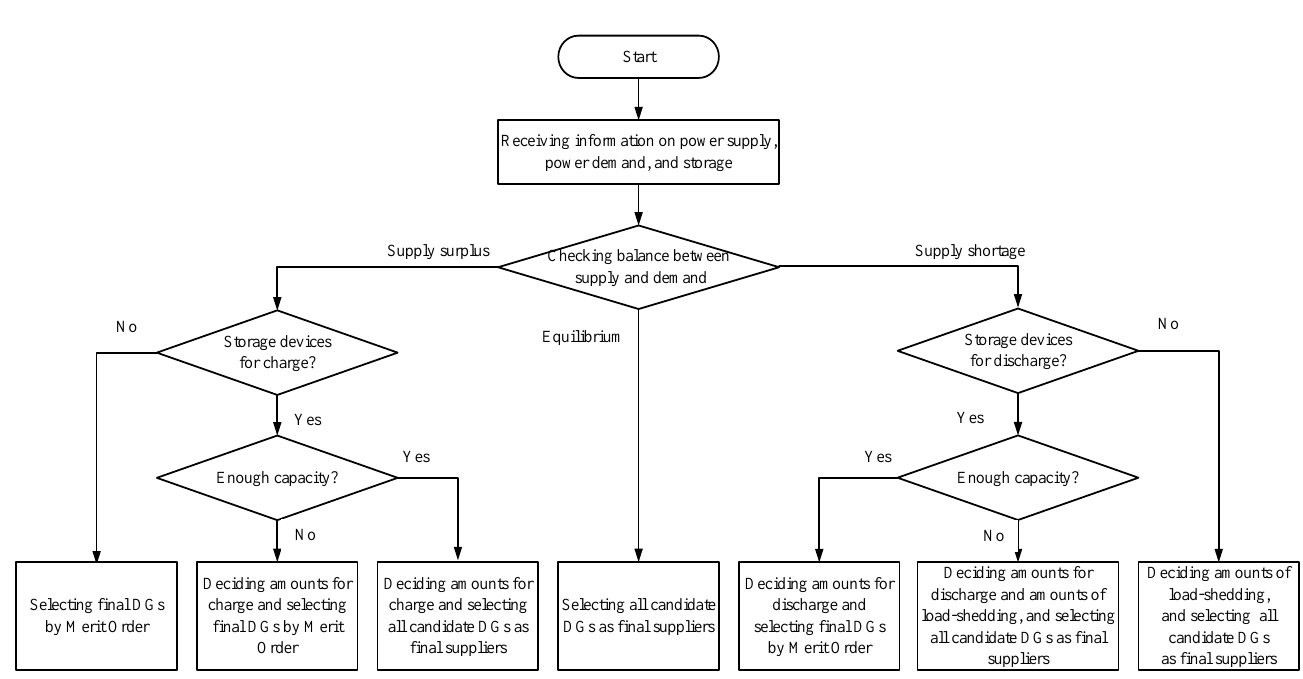
Figure 3. Cooperative operation